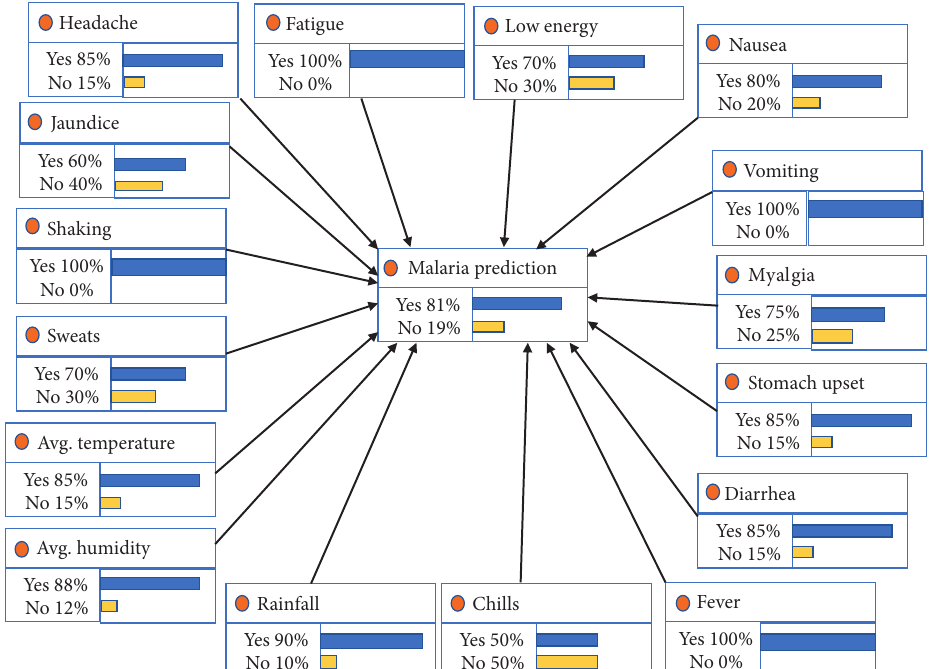
Figure 6: Proposed BN model predicted positive malaria disease.